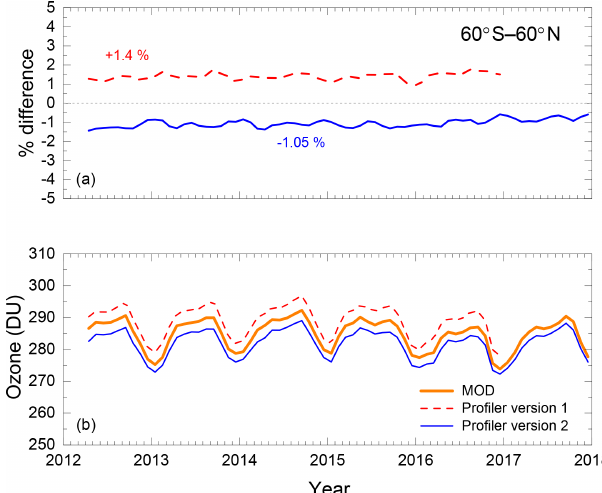
Figure 5. A similar plot for the OMPS nadir profiler shows that the large bias in the released version 1 data is reduced in the version 2